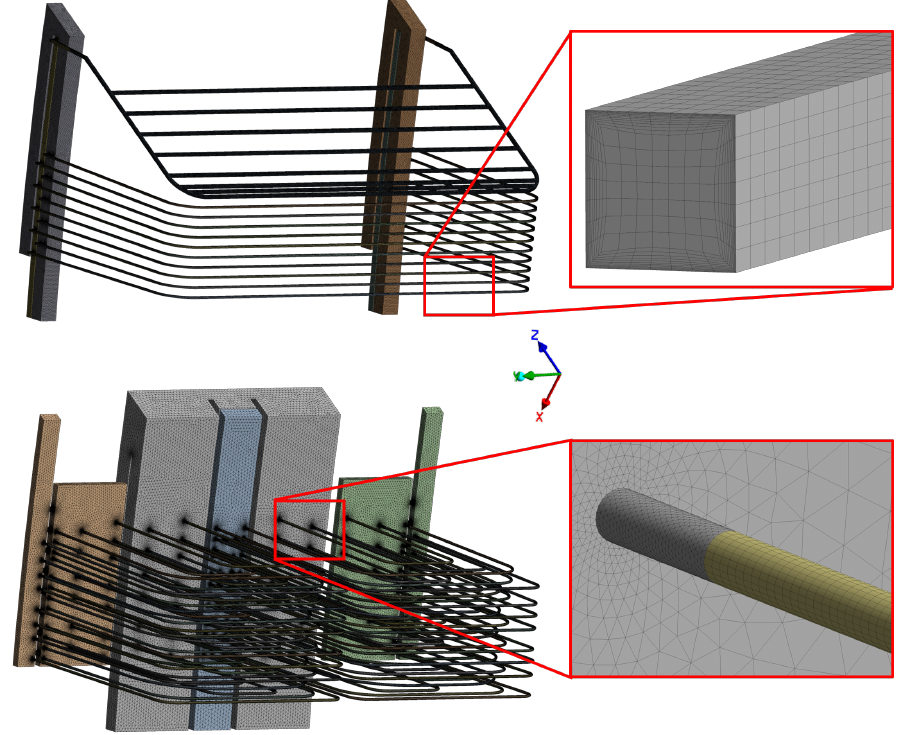
Figure 5. Water spatial discretization: SB ( top ) and BZ ( bottom ) cooling